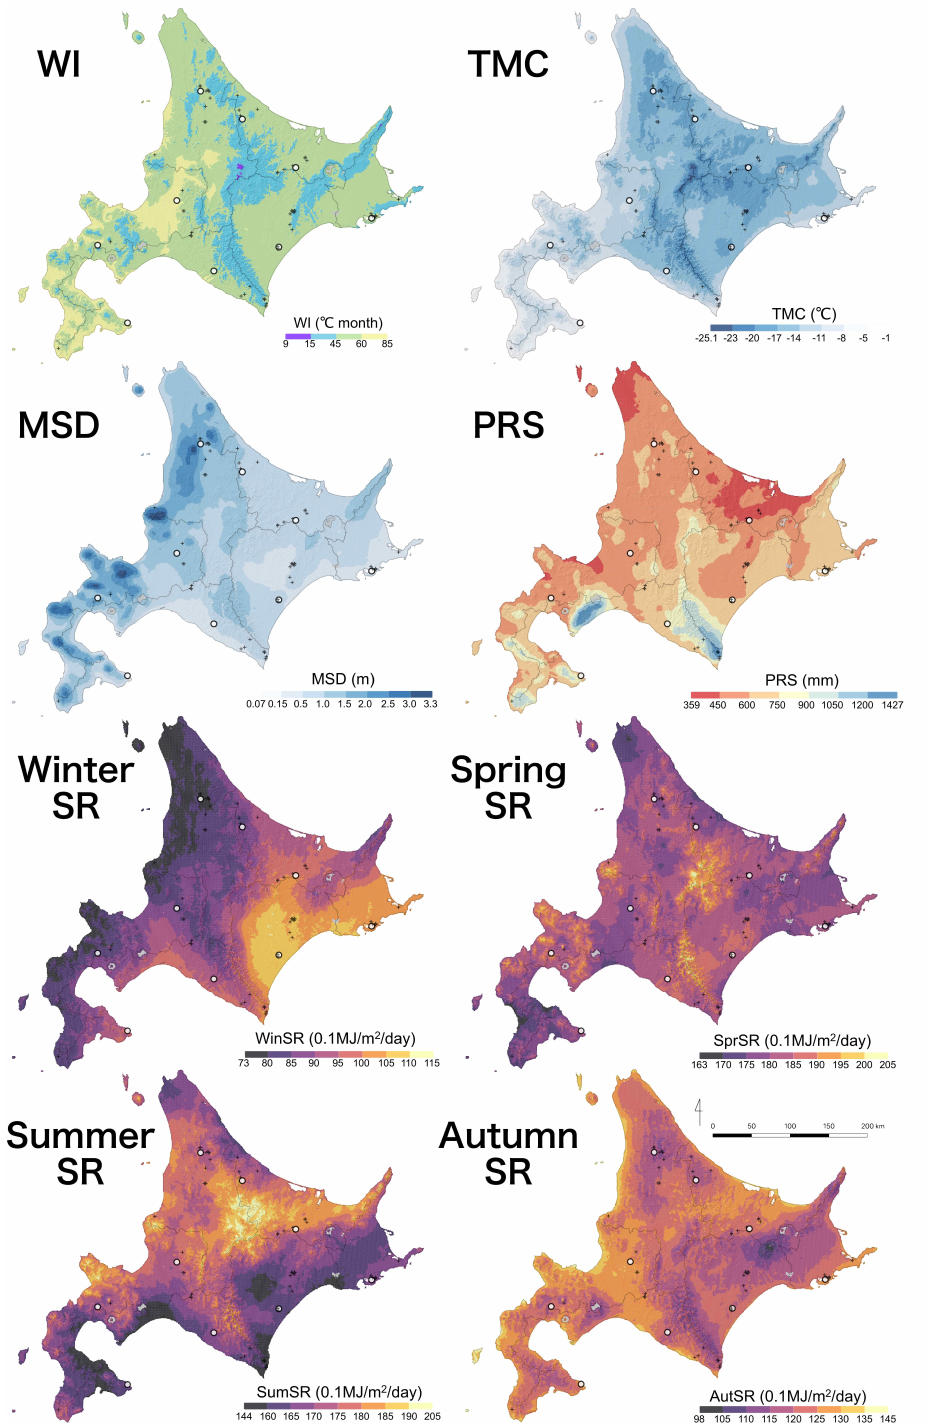
Figure 2. Maps for climatic variables used as explanatory variables. Open circles indicate testing sites, and plus signs indicate